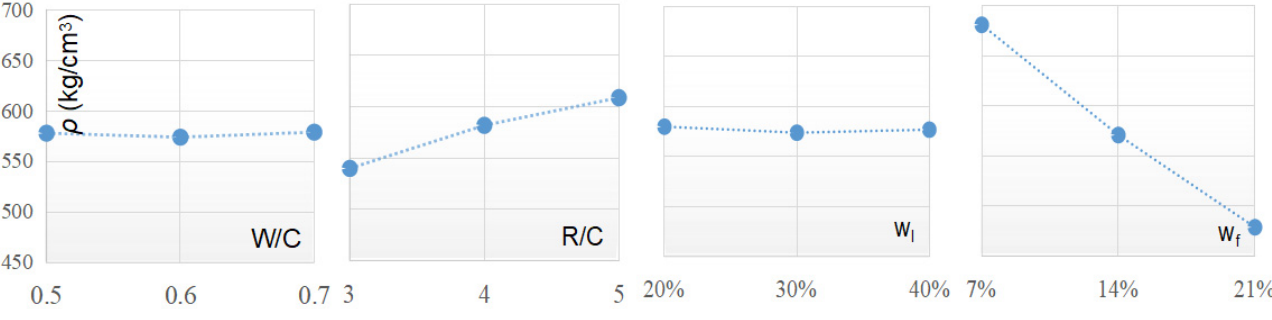
Figure 10. Intuitive analysis of the bulk density of four factors.